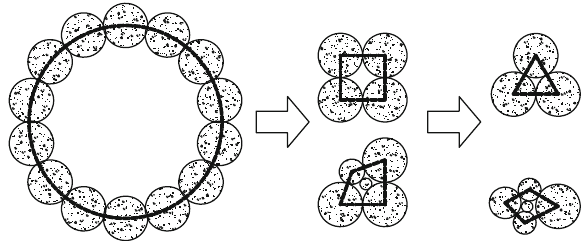
Figure 6: Changes in pore structure of broken coal and rock